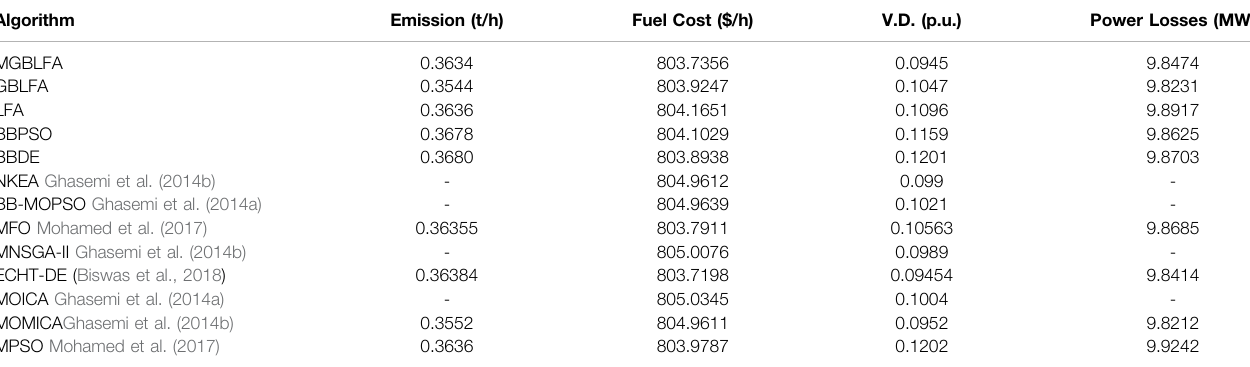
TABLE 8 | Comparison of optimal results by algorithms for Case 7. Algorithm